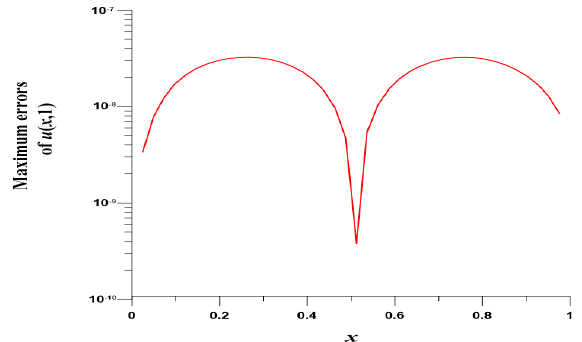
Figure 4. For Example 2 with l = 1: ME( u ) versus x at t f = 1.